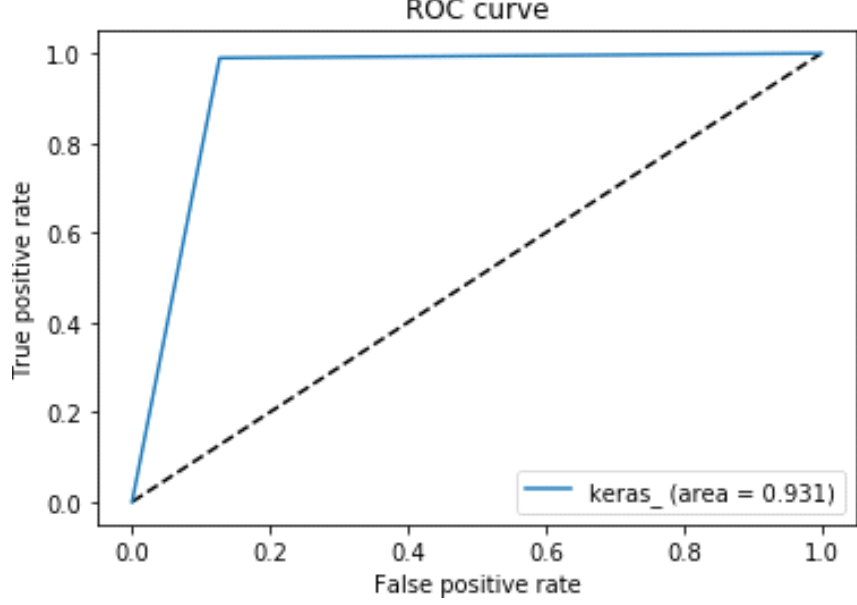
Figure 14: ROC curve for 70% training using BLSTM in frequency domain